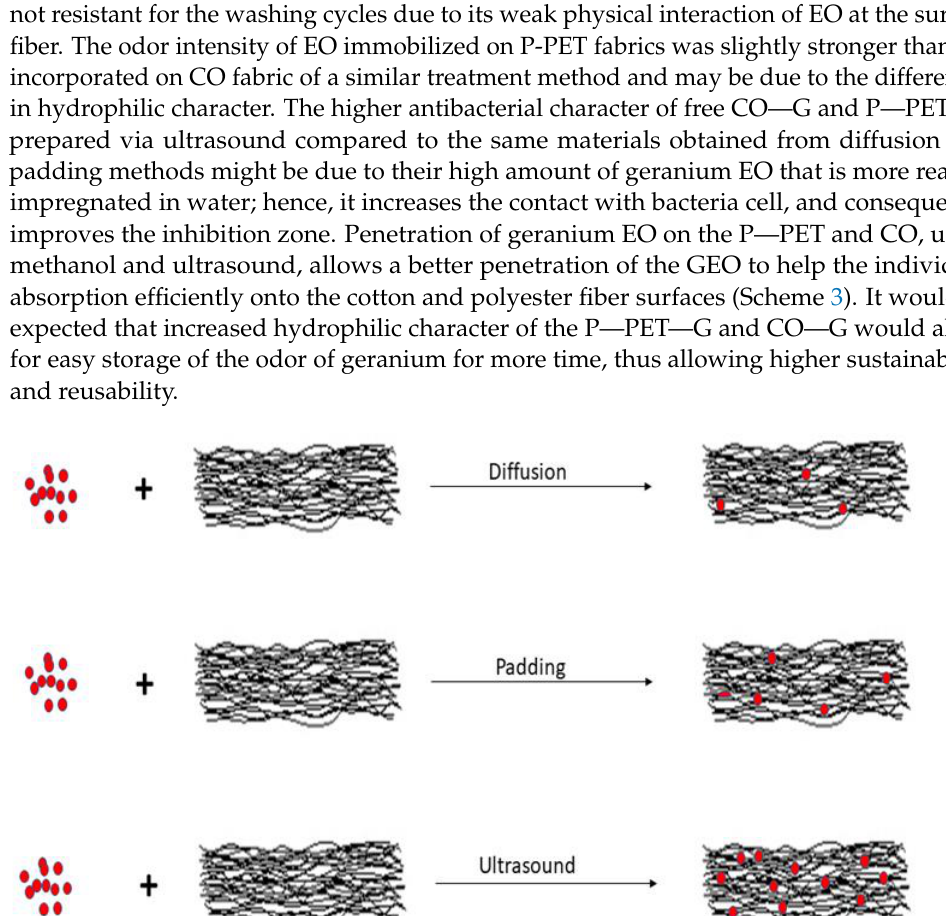
Figure 11. Change on the turbidity of different washing residue for different treatment methods ( a ) after the 1st washing and ( b ) after the third washing cycle, 1: P — PET — G and 2: CO — G. The results showed that ultrasound is more efficient than padding than diffusion, as explained by the high turbidity due to the presence not only of high concentration of ge- ranium oil but also the extent of immobilization and fixation of natural oil components (Figure 11). However, the diffusion method displayed clean residue suggesting that a neg- ligible amount of geranium EO that contains the residue. The results agree with those obtained by SEM, TGA, wettability, olfactory test, and antibacterial analysis. 5. Conclusions Based on this study, geranium oils incorporating textiles are of great importance be- cause of their ecofriendly and antibacterial properties. Three treatments process were evaluated in this work: ultrasound, diffusion, and padding. Results revealed that